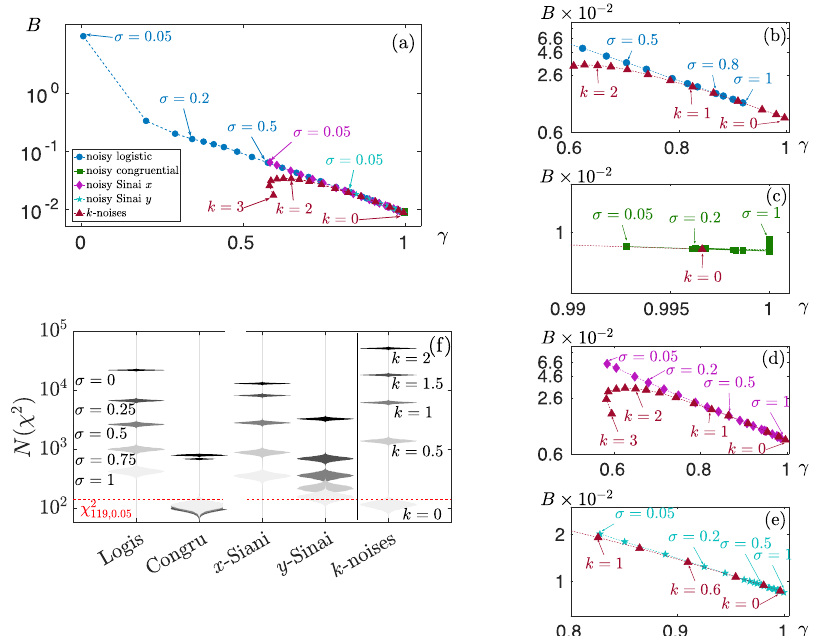
Fig. 3 Unobserved and distribution of visible ordinal patterns methodologies. a Characteristic decay rate B versus the stretched exponent γ for k -noises with k ∈ [0, 3] with step 0.2 (solid brown triangles) and logistic map (solid blue circles), congruential map (solid green squares), x -Sinai (solid magenta diamonds) and y -Sinai (solid cyan stars) with additive noise with σ ∈ [0, 1] with step 0.05. b – e Zoom of individual maps near the stochastic zone ( B ~ 10 − 2 and γ ~ 1). f Distribution N ( χ 2 ) of χ 2 for 10 4 independent realisations of all the noisy chaotic maps with additive noise with σ = 0.25, 0.5, 0.75 and 1, and k - noises with k = 0, 0.5, 1, 1.5 and 2. Dashed red line indicates the threshold χ 2 D ! (cid:3) , for D = 5 and α = 0.05. k : correlation degree and σ : intensity of the noise 1 ; α contamination.